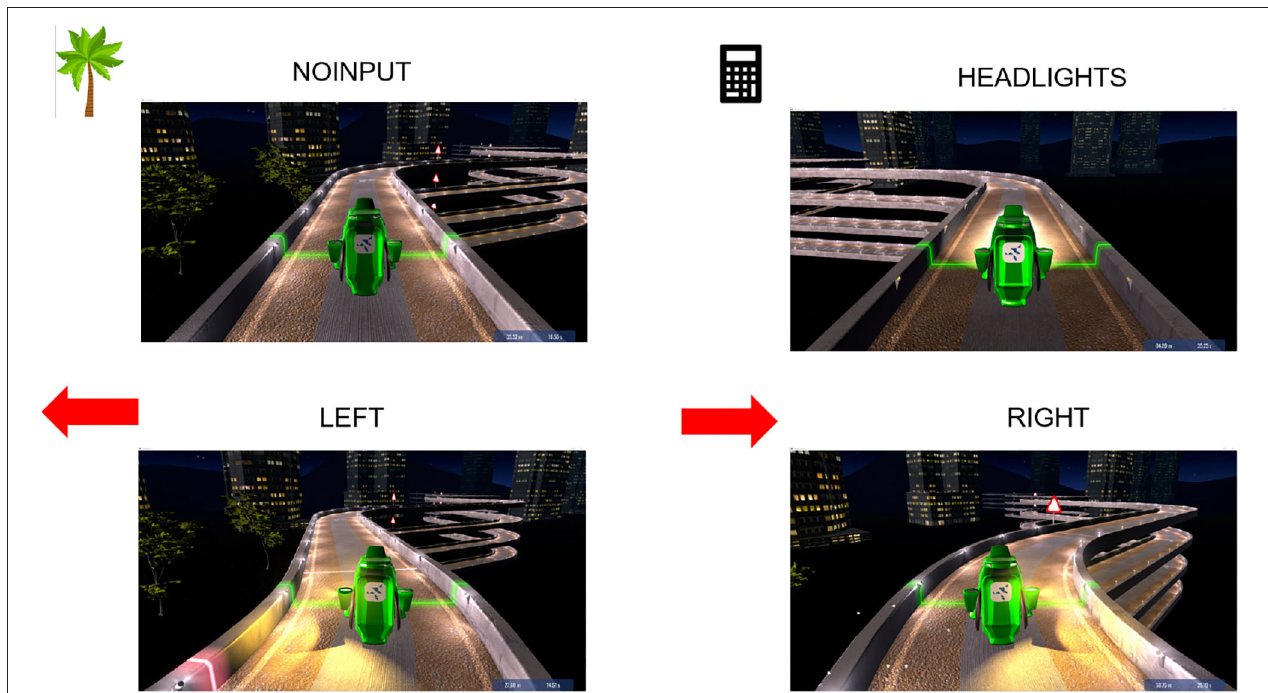
FIGURE 1 | CYBATHLON racing game. We chose a palm tree as the pictogram for the REST state (i.e., the NOINPUT command), a calculator for the MENTAL SUBTRACTION task (i.e., HEADLIGHTS command), and arrows pointing to the left and right for, respectively, LEFT and RIGHT-HAND motor imagery (i.e., turning LEFT and RIGHT